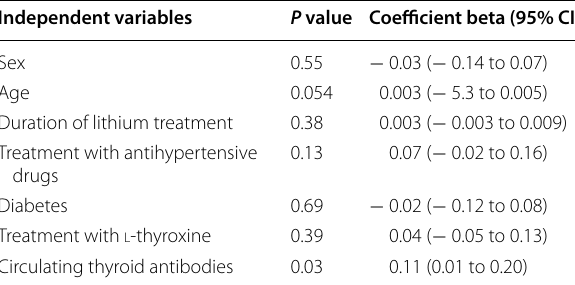
Table 4 Regression analysis using two different eGFR cat- egories (G1/G2/G3a; G3b) as the dependent variable Independent